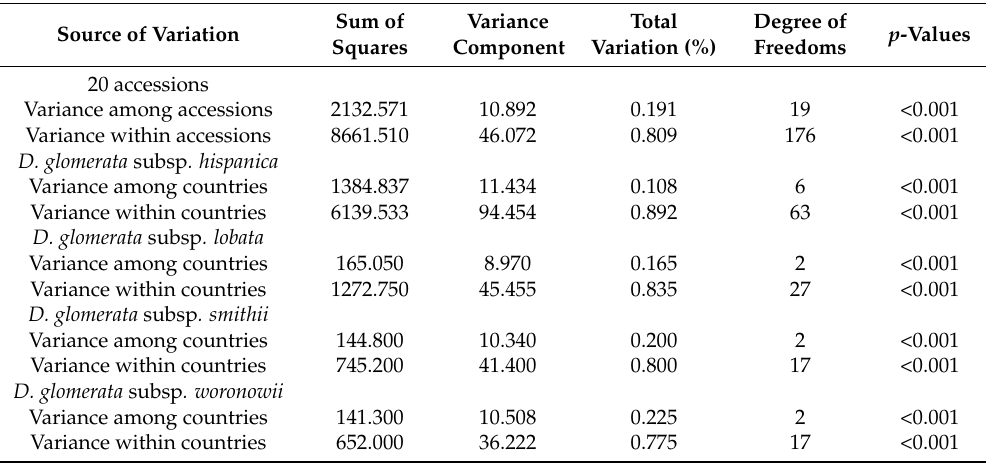
Table 4. AMOVA of 20 subspecies and across countries where